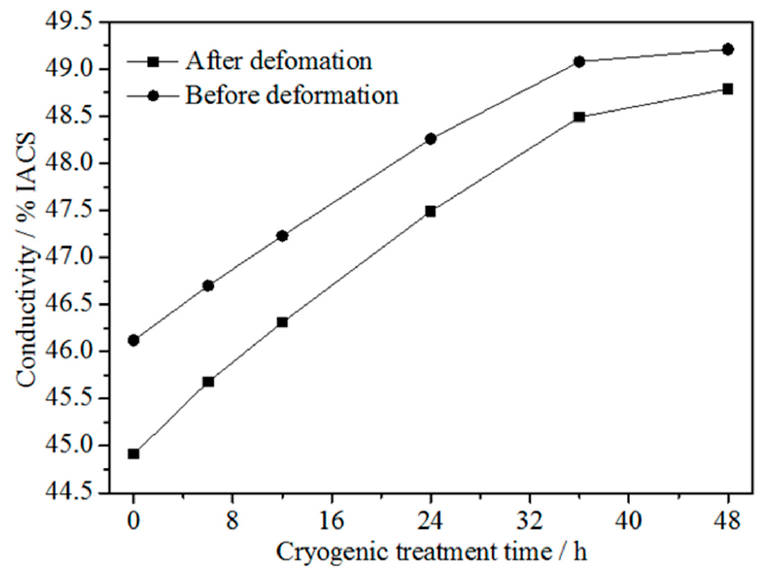
Figure 4. Conductivity of the Cu-1.34Ni-1.02Co-0.61Si alloy before and after cold rolling at 47% re- duction with the DCT time in liquid nitrogen.